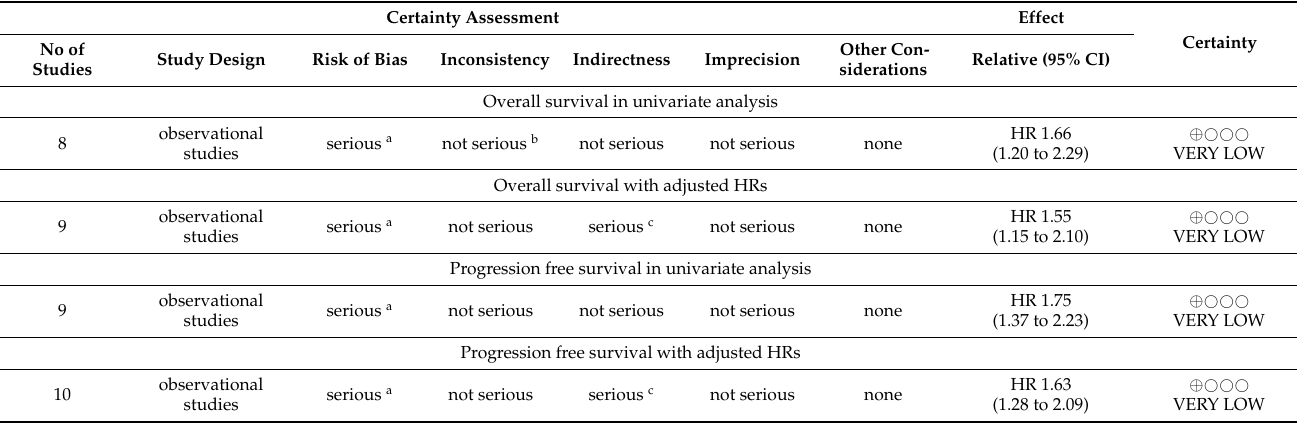
Table 3. Results of GRADE certainty assessment for evidence of impact of sarcopenia in patients treated with immune checkpoint